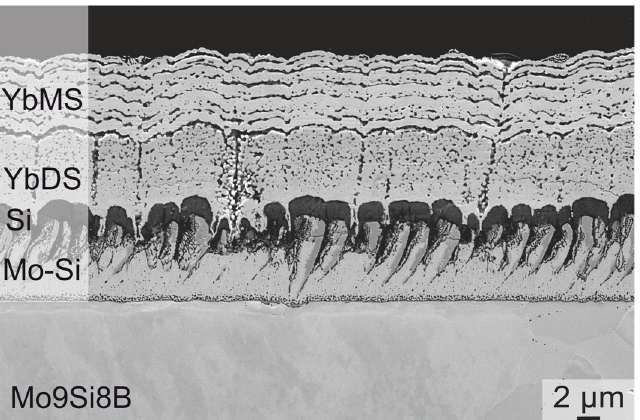
Figure 9. Secondary electron SEM micrographs of the bond coat and the YbDS and YbMS top layer on Mo-9Si-8B alloy after 100 h of oxidation test at 800 °C in air.